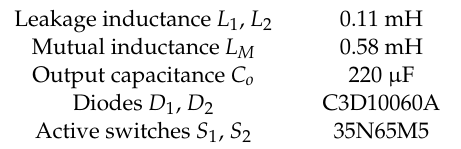
Table 2. Component parameters.